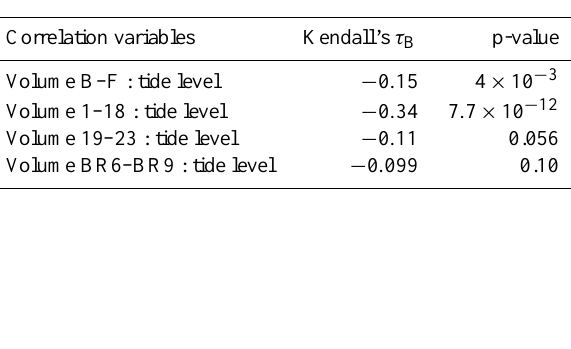
Table 7. Kendall’s τ B correlation coefficients and corresponding p- values between tide levels and beach volumes.